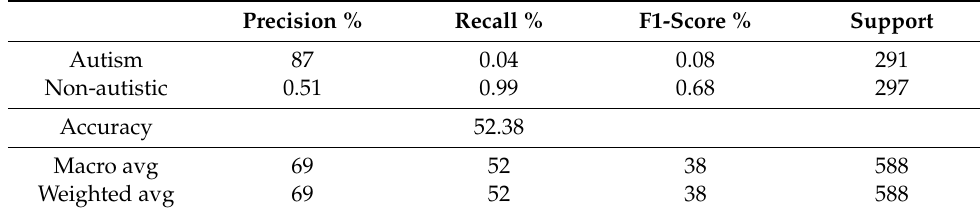
Table 9. Results of VGG-16 with KNN model.